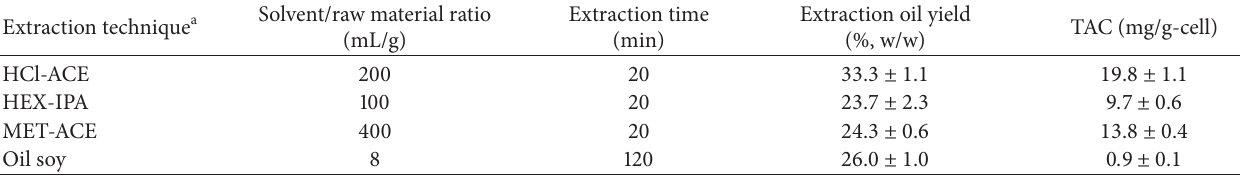
Table 2: Effect of different extraction methods on oil yield and total astaxanthin content (TAC) of extracts from H. Pluvialis cells. Extraction technique